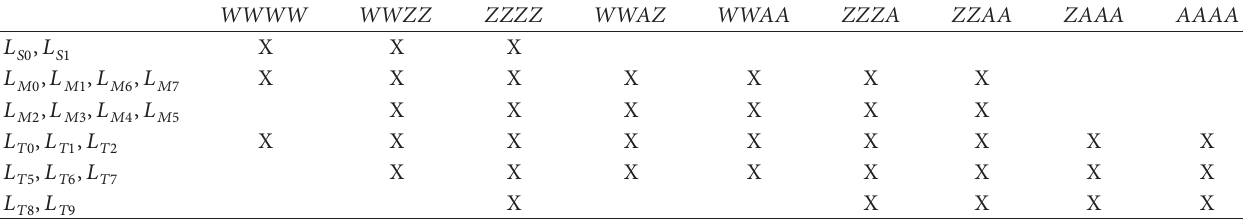
Table 1: Quartic vertices modified by each dimension-8 operator are marked with X